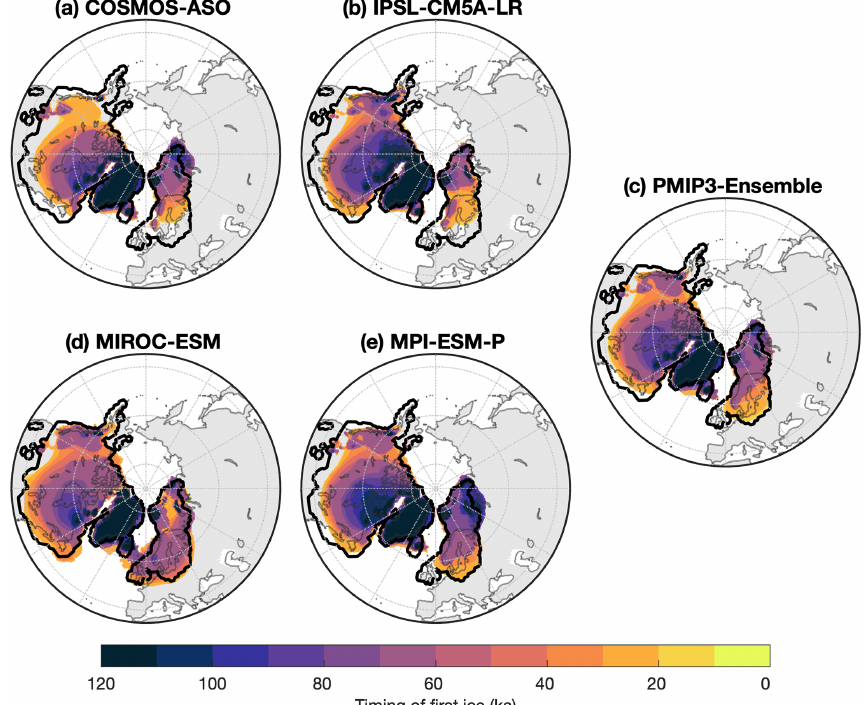
Figure 4. The time at which a region was first covered by ice during the LGC. Darker colours represent earlier inception. Lighter-colour re- gions were covered by ice later. The black contour depicts the ice extent reconstruction Abe-Ouchi et al. (2015) used in the GCM simulations. Each simulation was forced by GCM output from PMIP3 interpolated using the climate matrix method.